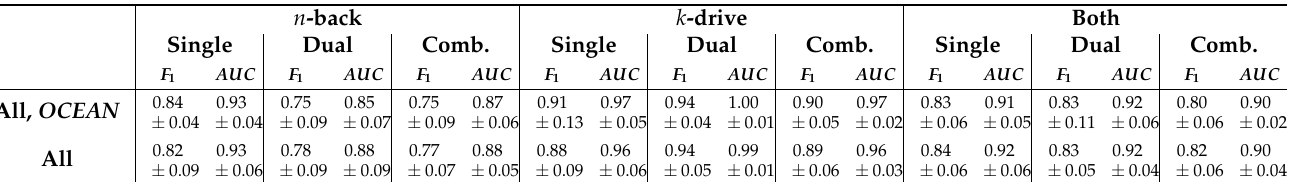
Table A1. Results of the trained classifier using the same evaluation protocol described in Section 2.14 for a XGBoost classifier with and without attached ocean scores and all biosignal, eye tracker and action unit